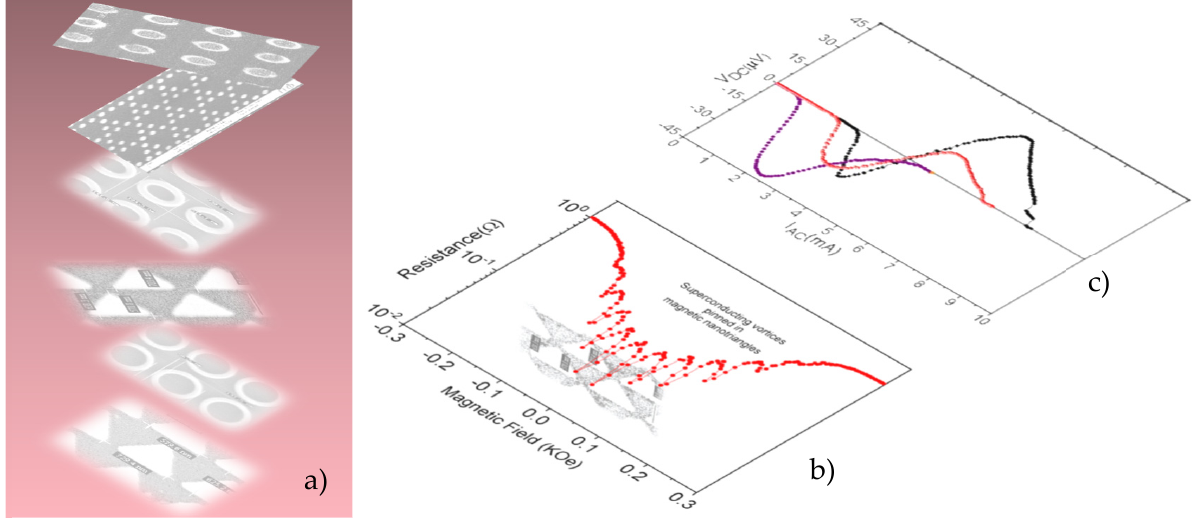
Figure 1. Magnetic pinning center designs ( a ), magnetoresistance measurements ( b ), and ratchet effects ( c ) of superconducting vortices from magnetic nanostructures with different shapes in hybrid Nb/Ni superconductor/magnetic devices, from [37–40,42–44] Reprinted/adapted with permission from Ref. [38] © 2011 American Physical Society. Such hybrid devices represent a clear example of how superconducting and magnetic properties can be properly combined and tailored at relevant interacting length scales to achieve controllable effects, which can tune the electronic response of these devices through the superconducting–magnetic interaction at the